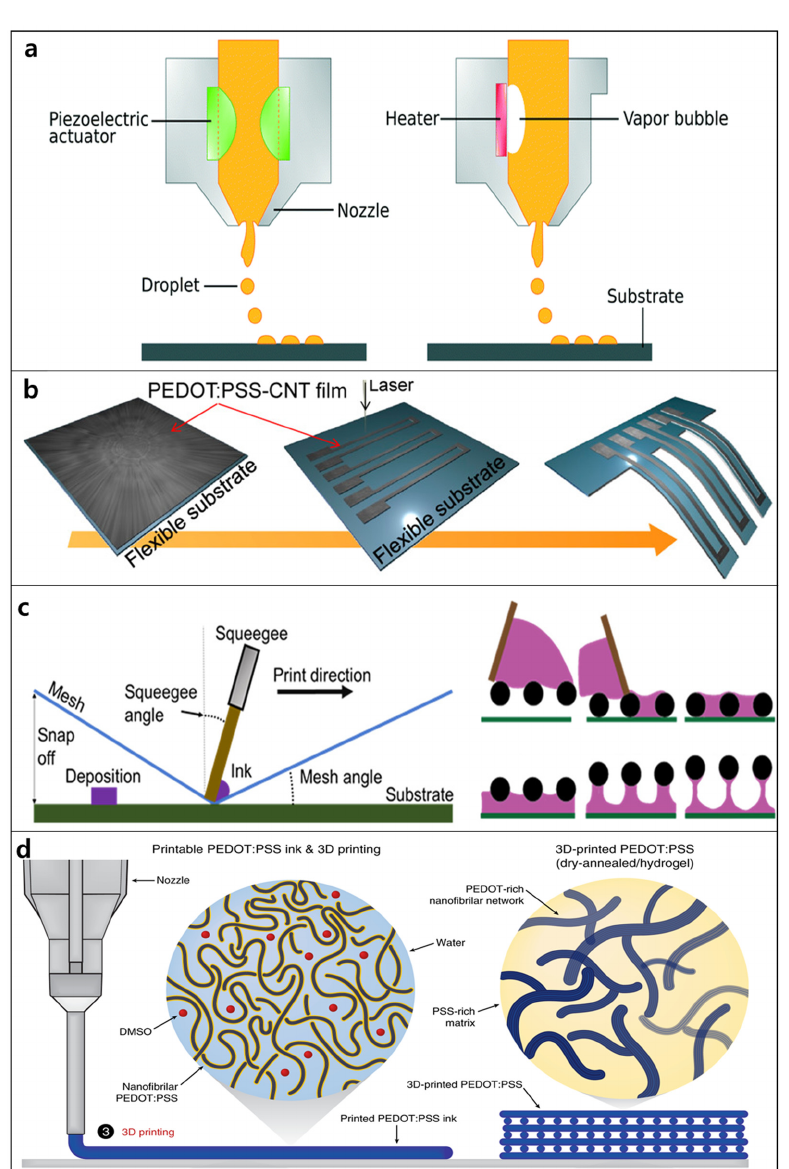
Figure 3. Schematics of ( a ) the inkjet printing process: piezoelectric mode and thermal mode (Reproduced with permission from ref [137]); ( b ) preparation of PEDOT:PSS/CNT film-based artificial electronic whisker using inkjet printing (Reproduced with permission from ref [145]); ( c ) the ink transfer process from screen to substrate and the three stages of screen printing (Reproduced with permission from ref [147]); ( d ) fabrication of a 3D-printable conducting polymer ink (Reproduced with permission from ref [155]).